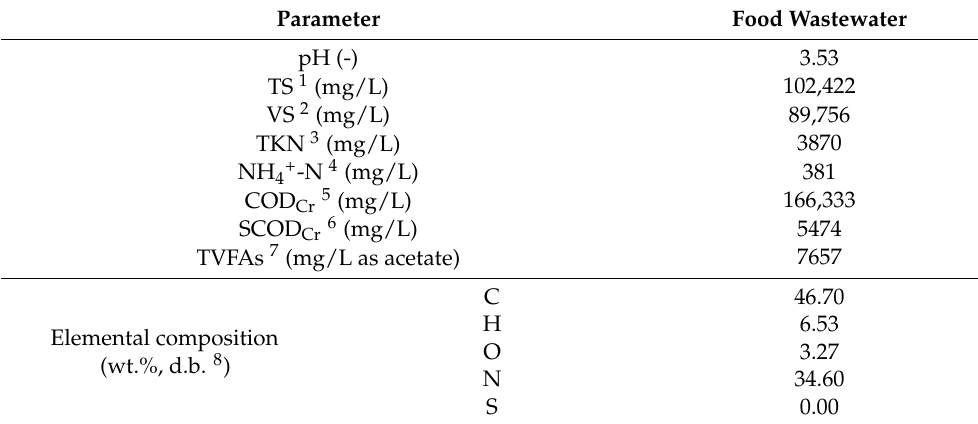
Table 1. Chemical composition and theoretical methane potential of food